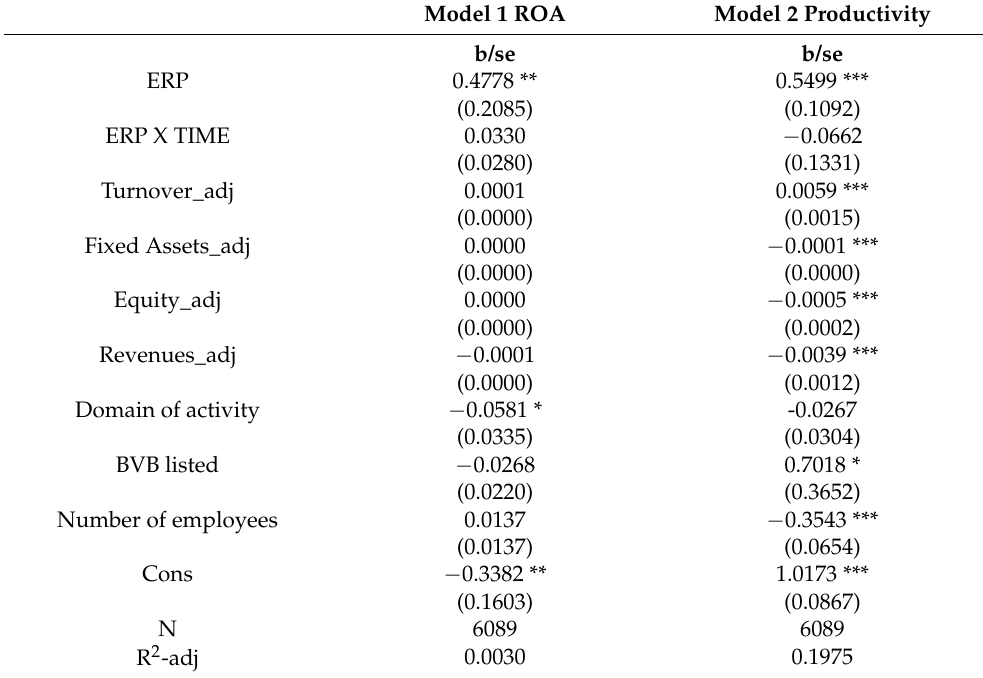
Table 8. Results regarding the influence of ERP on ROA and productivity of companies considering the moment of